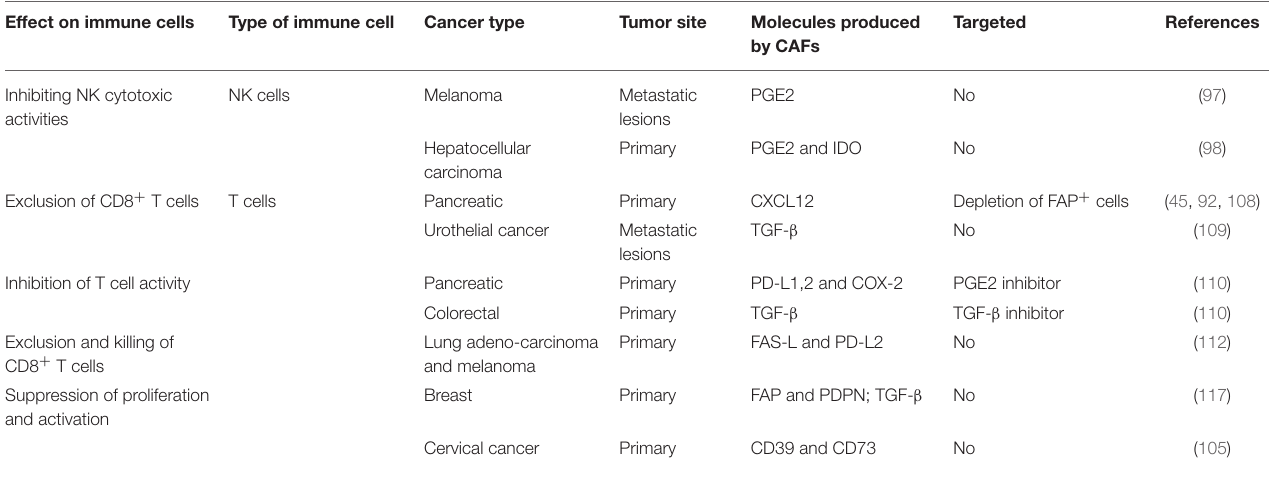
TABLE 3 | CAF-mediated inhibition of anti-tumor